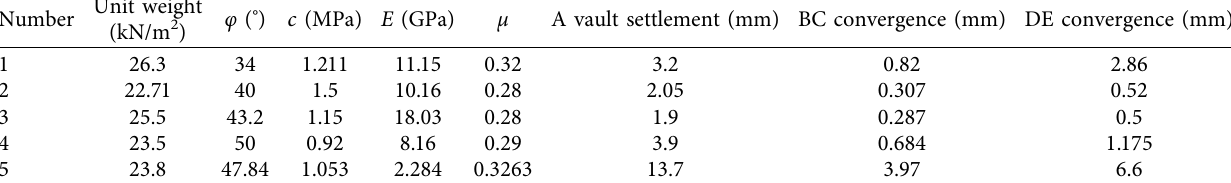
Table 3: Testing set.